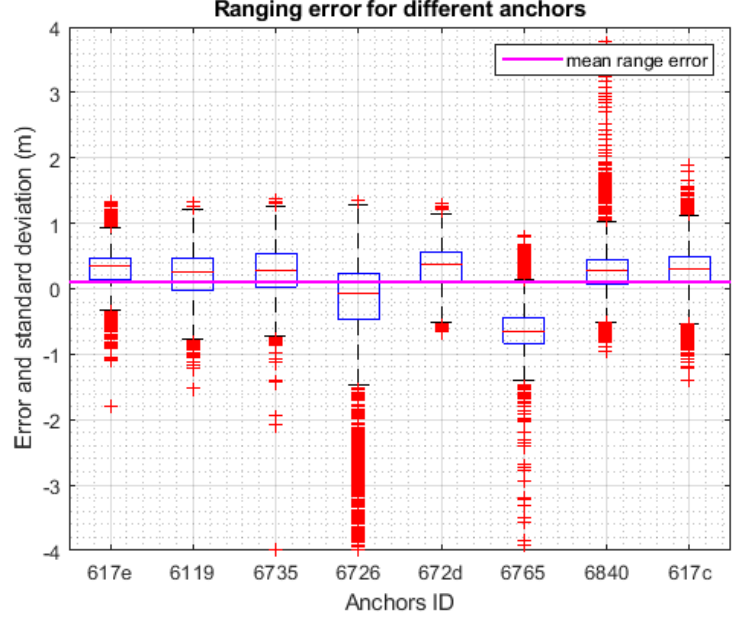
Figure 7. Ranging error of Pozyx UWB system for each anchor. Figure 7 . Ranging error of Pozyx UWB system for each anchor.